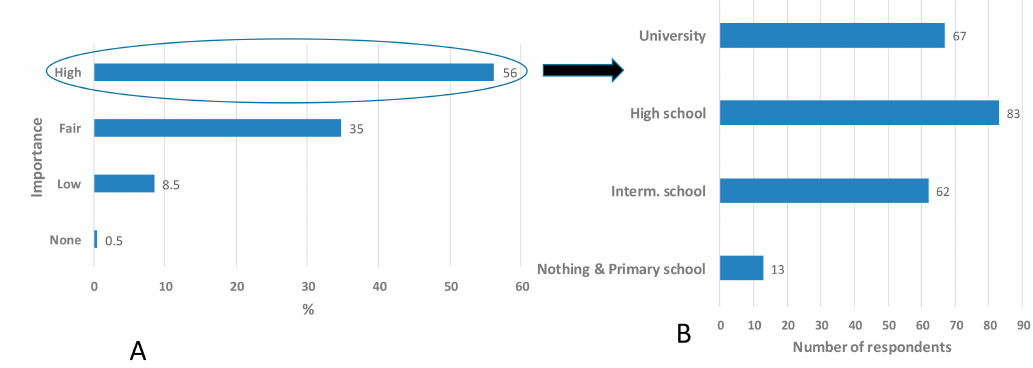
Figure 4. ( A ) Distribution of answers to the question: “How much importance do you attribute to the care and safeguard of the urban landscape of Ferrara?” and ( B ) distribution of educational level of respondents exhibiting high